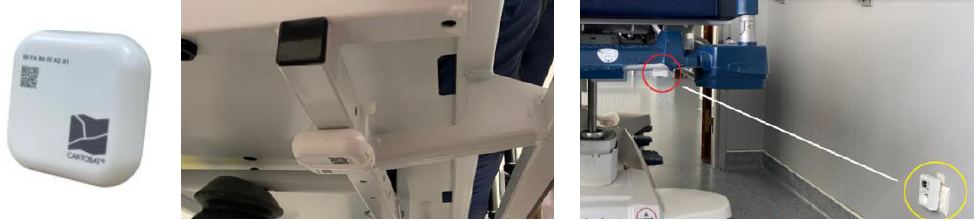
Figure 5. A typical tag mounted on a stretcher. The yellow circle in the right figure shows a plugged CartoModule. CartoModule.